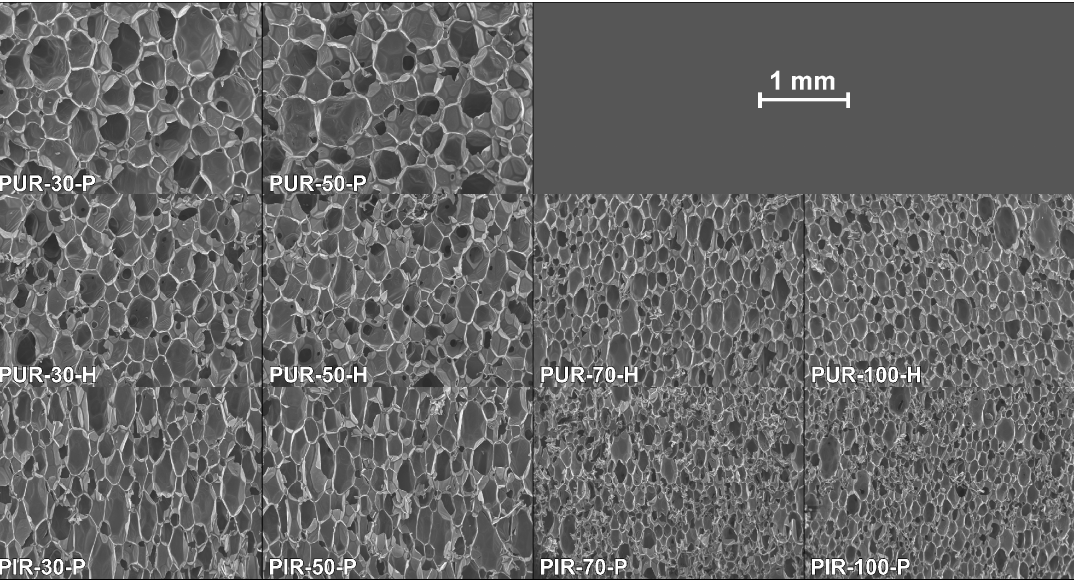
Figure 1. SEM micrographs of the cell structure of all tested materials.